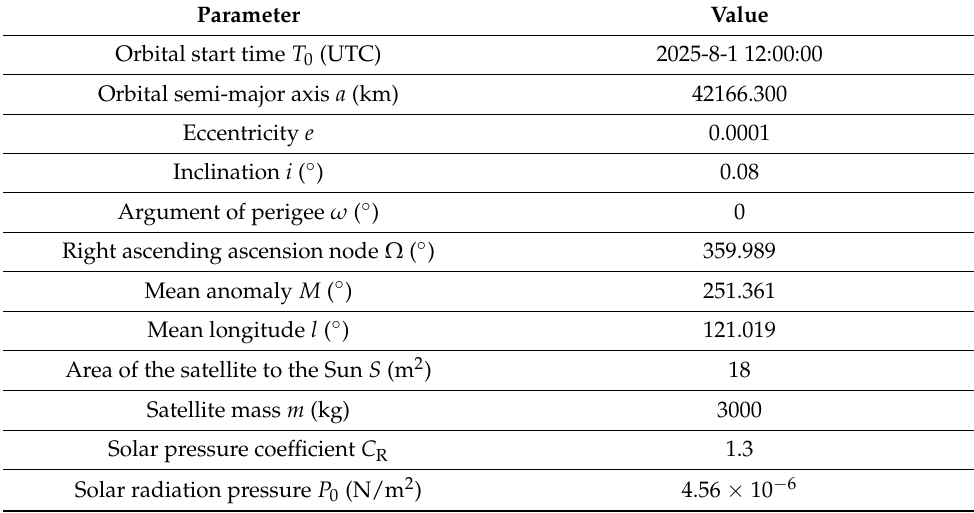
Table 1. Initial orbit used for simulation.